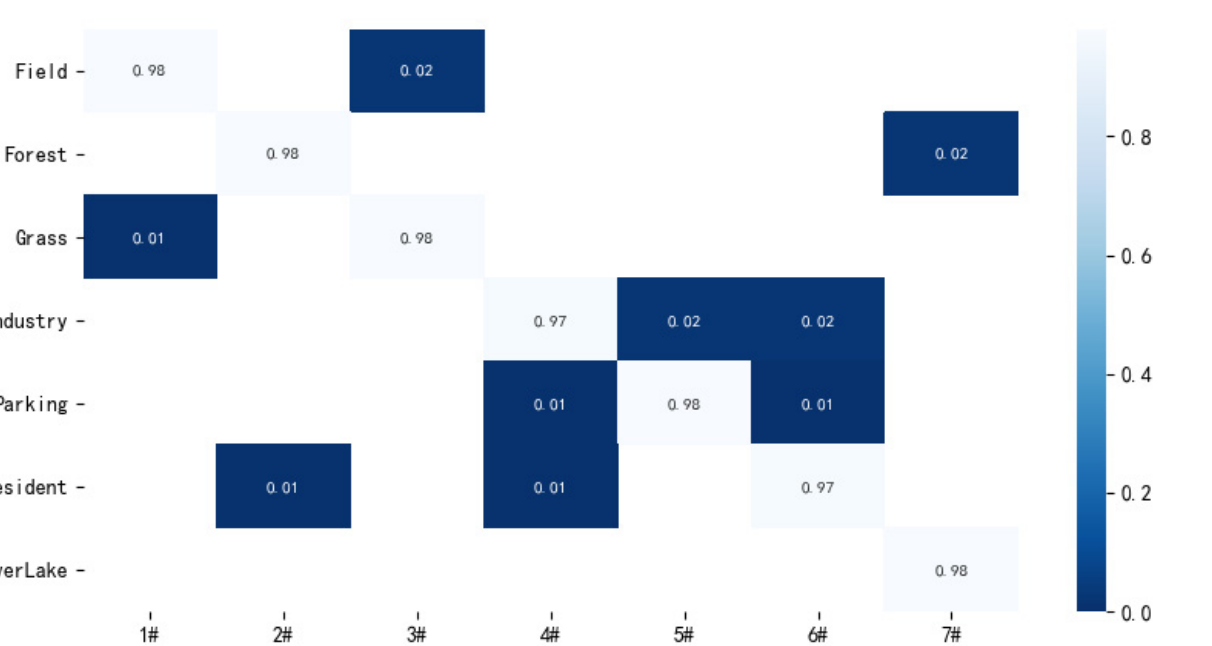
Table 3. Comparison of OA and parameters between the proposed method and some advanced methods on the RSSCN dataset with 50% training ratio.